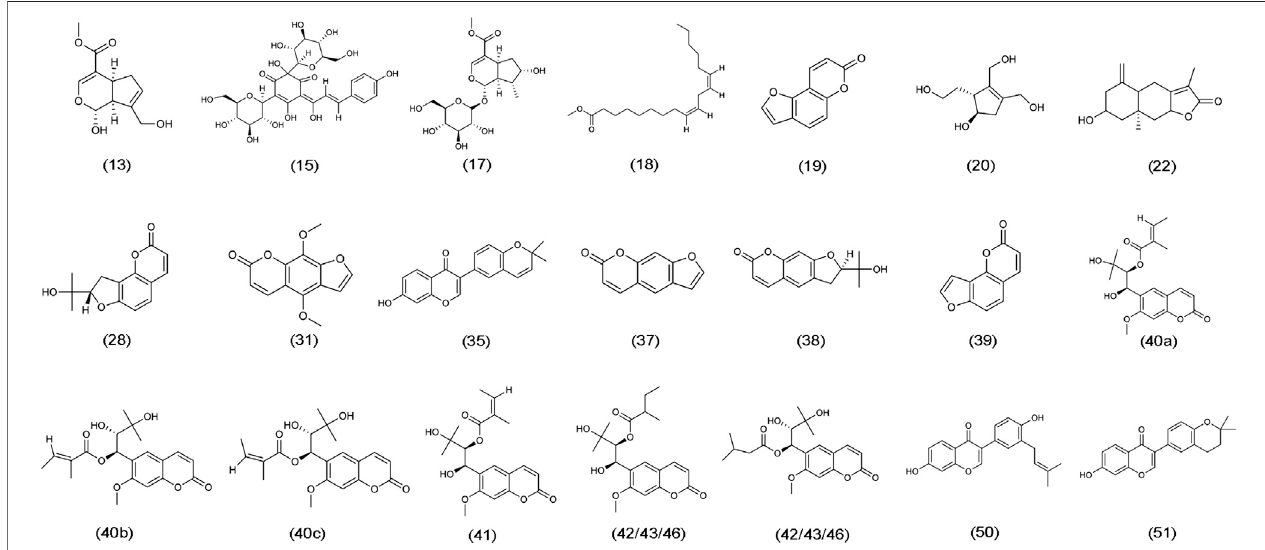
FIGURE 4| Chemical structure formulae of 20 compounds absorbed into the blood. Chemical structuresand formulae of 20 compounds from PubChem (https:// pubchem.ncbi.nlm.nih.gov/), numbered according to the TIC presented in Figure 3 and compounds information in Supplementary Table S2 .